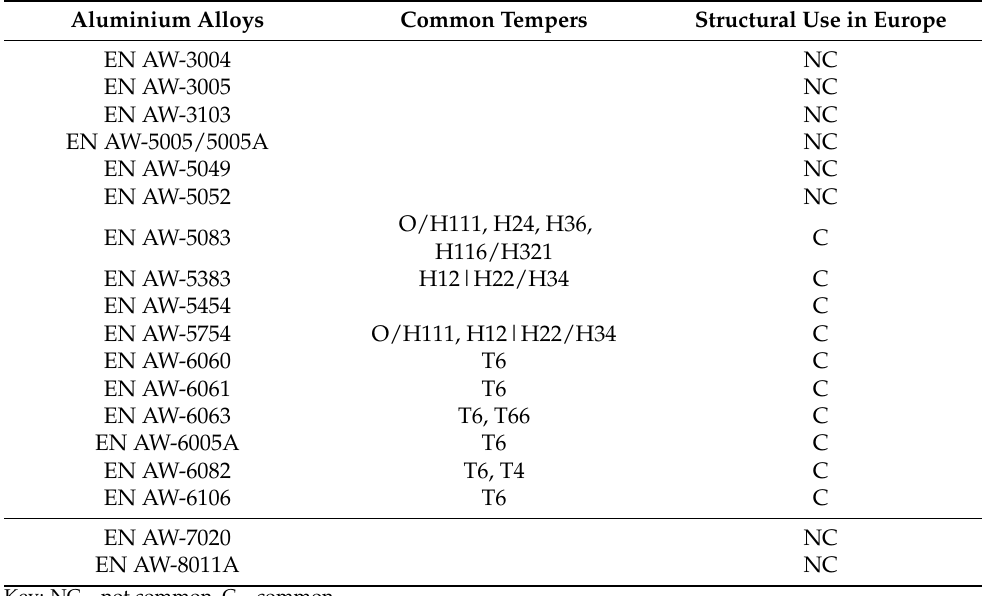
Table 1. Wrought aluminium alloys to be used in structural applications according to EN 1999-1-1 [15]. Aluminium Alloys Common Tempers Structural Use in Europe EN